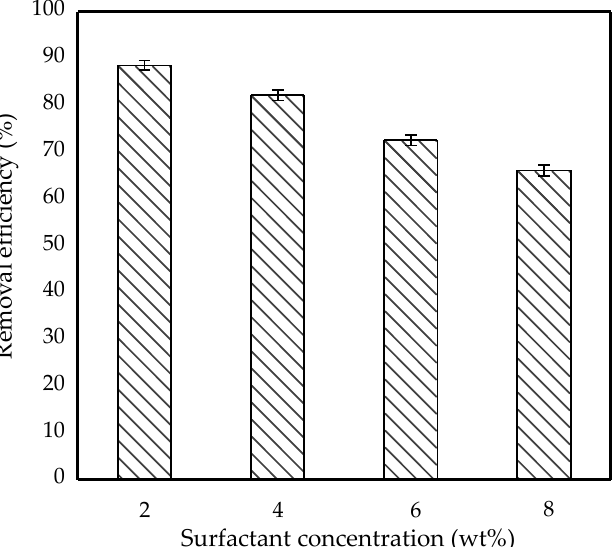
Figure 9. Effect of surfactant concentration on removal efficiency of 10 ppm IBP. (Condition: [TOA] = 6 wt%; Stirring speed = 300 rpm; Emulsification time = 20 min; O/I = 3:1; Kerosene = 30 mL).